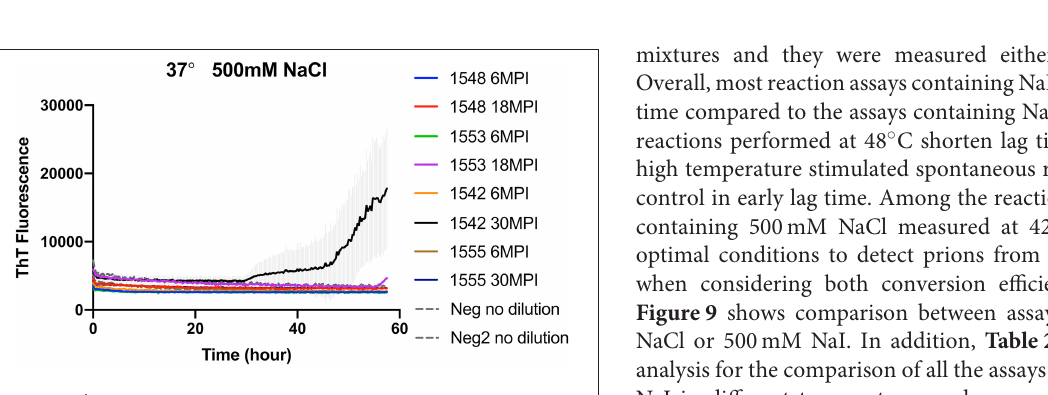
FIGURE 5 | RT-QuIC reactions seeded with biopsy fecal homogenates from preclinical white- tailed deer. RT-QuIC reactions were seeded with 10 − 1 dilution of 10% fecal homogenate. All reaction mixtures contain 500mM NaCl and measured at 37 ◦ C. Shown are the average ThT fluorescence readings determined from all replicates (four replicate reactions per each